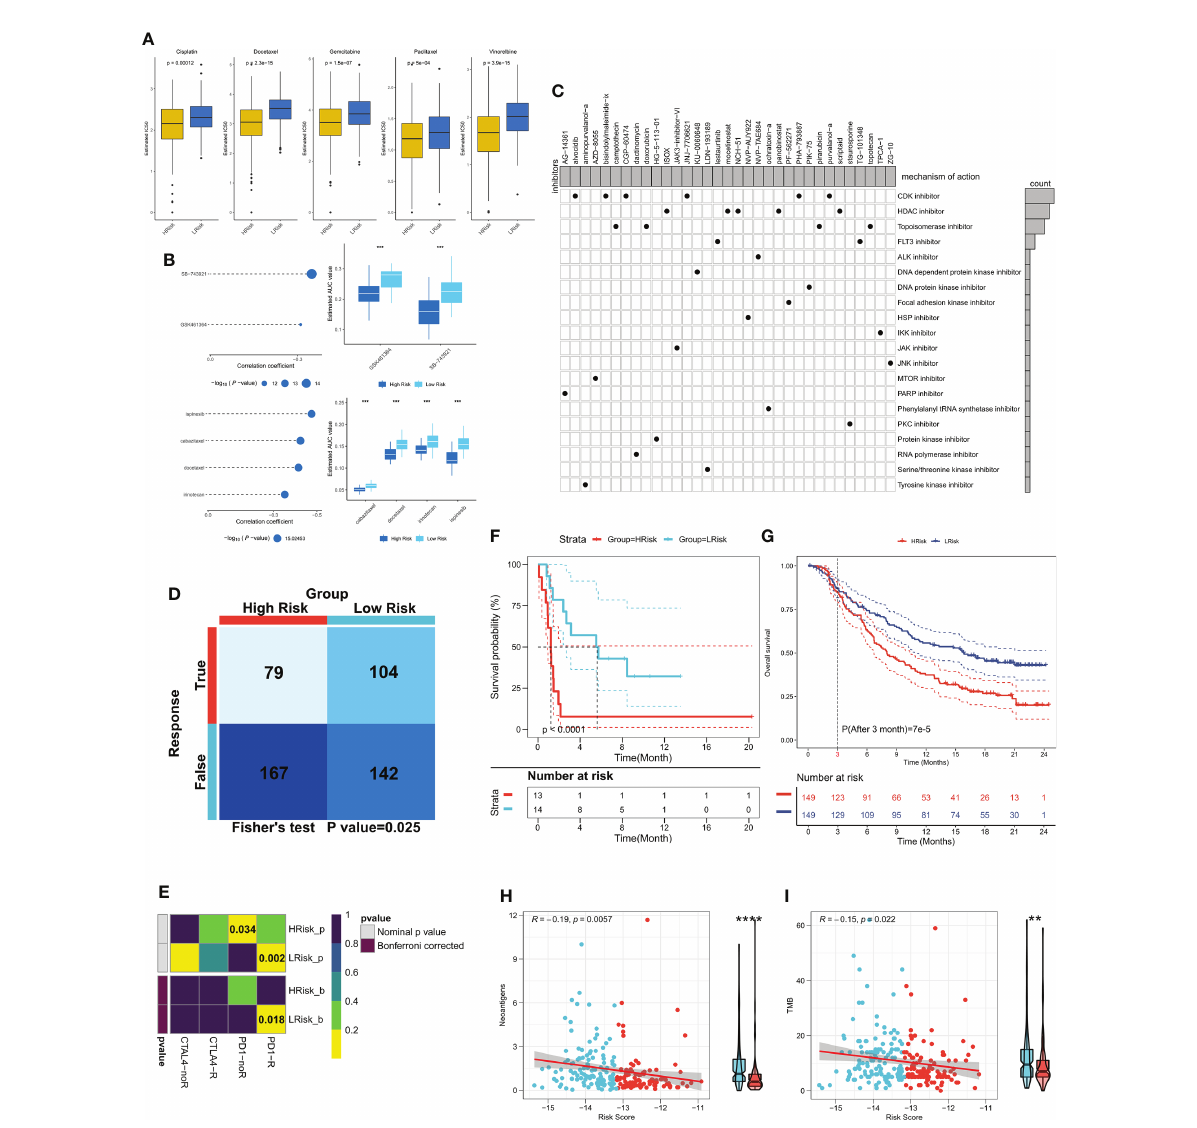
FIGURE 8 CRGs-related deep learning model in guidance of clinical treatment decisions. (A) Box plot showing the predicted IC50 values of fi ve commonly used drugs in the high-risk and low-risk groups. (B) Spearman correlation analysis and differential drug analysis of small molecule compounds and Risk Score. Top: CTRP database; bottom: PRISM database. (C) Oncoplot represents the identi fi ed small molecule compounds, with the horizontal axis representing the small molecule inhibitor name and the vertical axis representing the biological pathway targeted by the small molecule inhibitor. (D) The TIDE algorithm was used for predicting the response of the two risk groups to immunotherapy. (E) Subclass mapping was employed to predict the sensitivity of patients in both risk groups to PD1 and CTLA4 treatments. (F) KM survival curves for both risk groups in the NSCLS immunotherapy cohort. (G) KM survival curves for the two risk groups in the IMvigor210 cohort. (H) The correlation between risk score and neoantigens in the IMvigor210 cohort; (I) The correlation between risk score and TMB in the IMvigor210 cohort. **P < 0.01, ***P < 0.001, ****P <